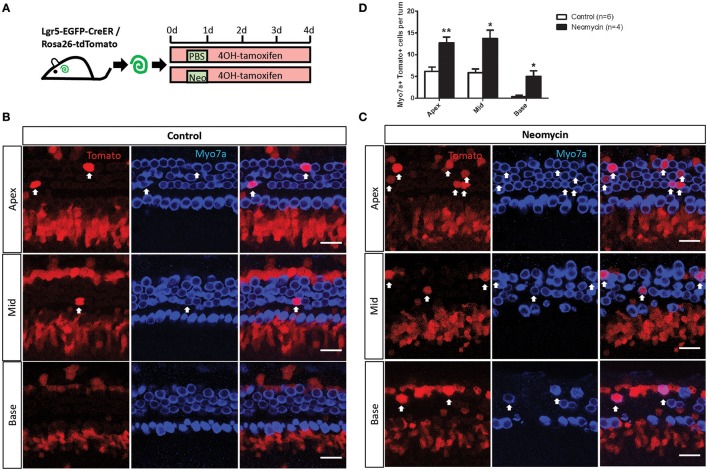
In vitro lineage tracing of Lgr5+ cells in the neomycin-treated and untreated cochleae of postnatal mice. (A) 4OH-tamoxifen was added to the culture medium of P1 Lgr5-EGFP-creER/Rosa26-tdTomato mouse cochleae throughout the entire culture period. Neomycin was added at 12 h after the start of the culture and was allowed to incubate for 12 h, and the same amount of PBS was added to the untreated cochlear culture medium for the same amount of time. The cochleae were examined after 4 days of culture. (B,C) Images of the neomycin-treated and untreated cochleae show that tdTomato+/Myo7a+ cells were found in the outer hair cell subset (arrow) in the apical, middle, and basal turns. (D) The cochleae were divided into three equal parts by length (apex, middle, and base), and all of the tdTomato+/Myo7a+ cells in each turn of the neomycin-treated cochleae and untreated cochleae were counted and statistically analyzed. *p < 0.05, **p < 0.01, n is shown in parentheses. Scale bars are 20 μm in (B,C).